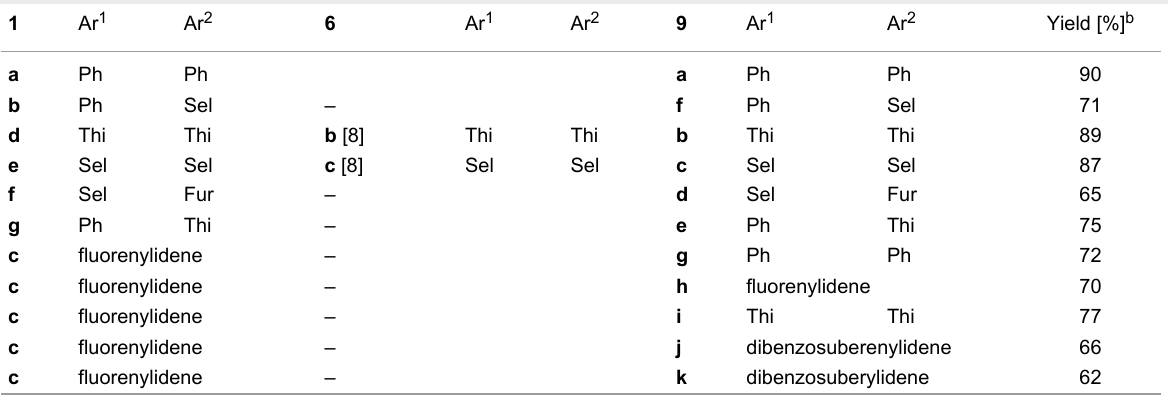
Table 1: Synthesis of tetraaryl/hetarylethenes 9a − f and dibenzofulvenes 9g − k from diaryl thioketones 1 and TMS-CHN 2 .